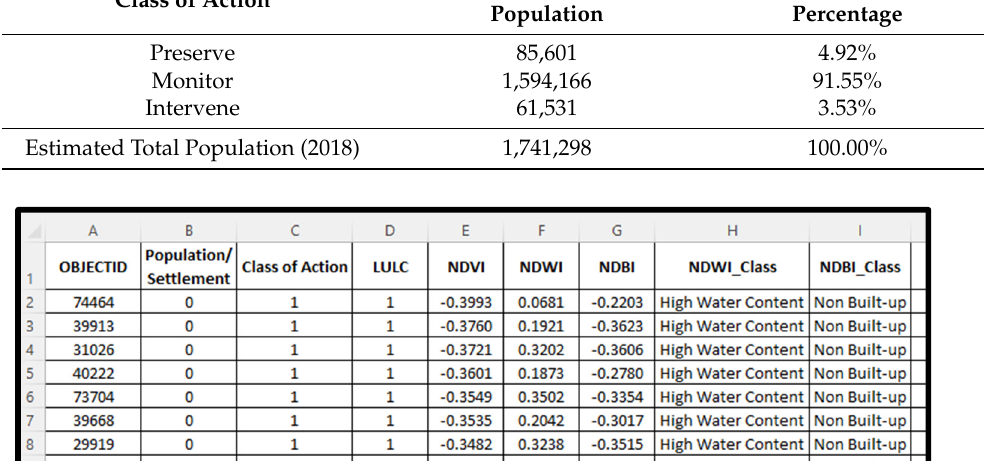
Table 16. Distribution of Built-up category per IUHI class of action based on NDBI.